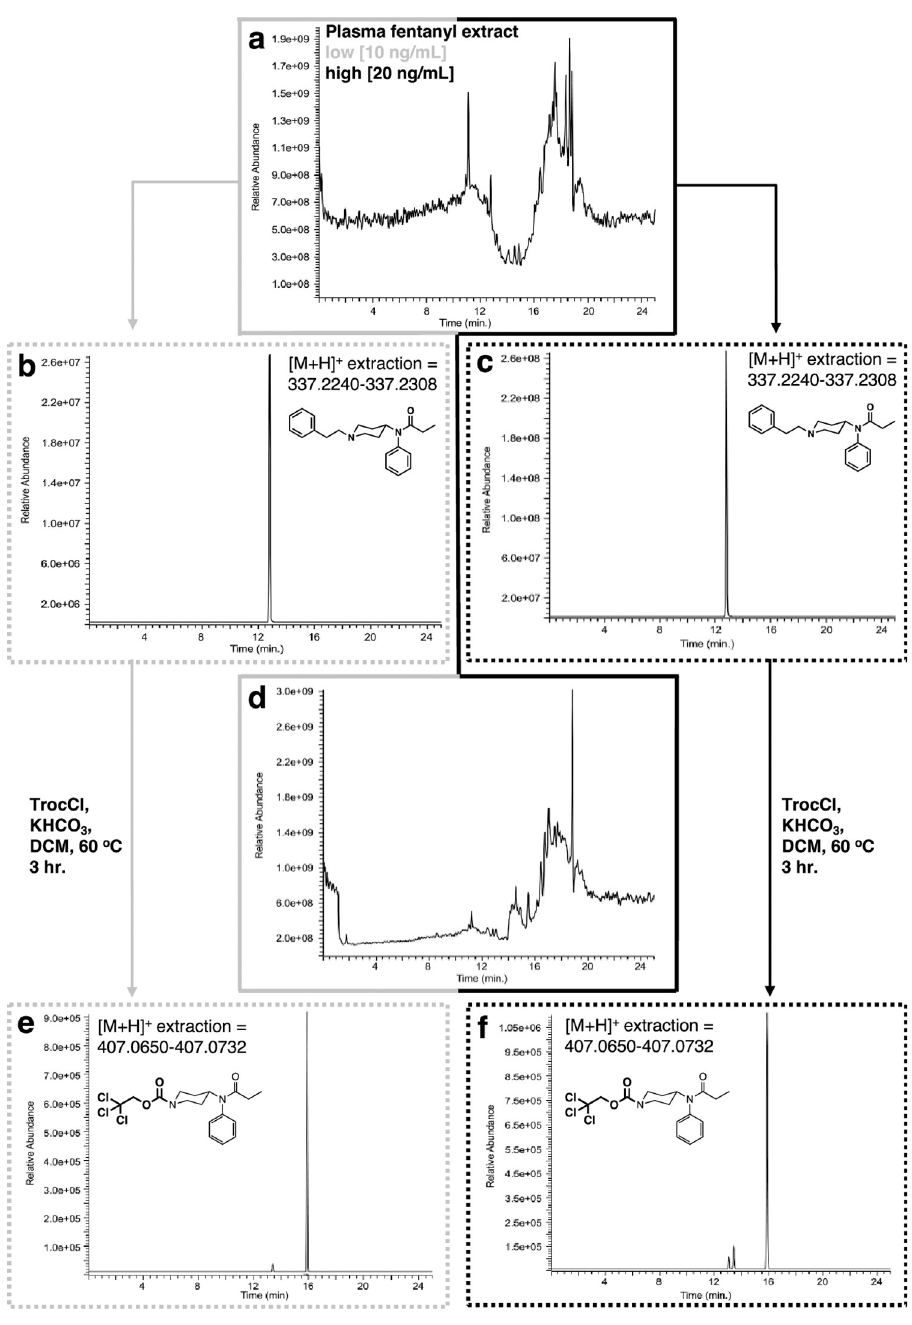
Fig 11. Analysis by HR-LC-MS of extraction and reaction of fentanyl with Troc-Cl when spiked in plasma. (a) Total ion chromatogram (TIC) of extracted plasma sample; (b) extracted ion ([M+H + ] = 337.2274 ± 5 ppm) for fentanyl (rt = 13.85 min.) for low concentration plasma sample (10 ng/mL); (c) extracted ion ([M+H + ] = 337.2274 ± 5 ppm) for high concentration in plasma sample (20 ng/mL); (d) Total ion chromatogram (TIC) of reaction between extracted plasma sample with Troc-Cl; (e) extracted ion ([M+H + ] = 407.0691 ± 5 ppm) for Troc- norfentanyl for low concentration spiked plasma sample; (f) extracted ion ([M+H + ] = 407.0691 ± 5 ppm) for Troc- norfentanyl for the high concentration spiked plasma sample showing its appearance at rt = 15.91 min.